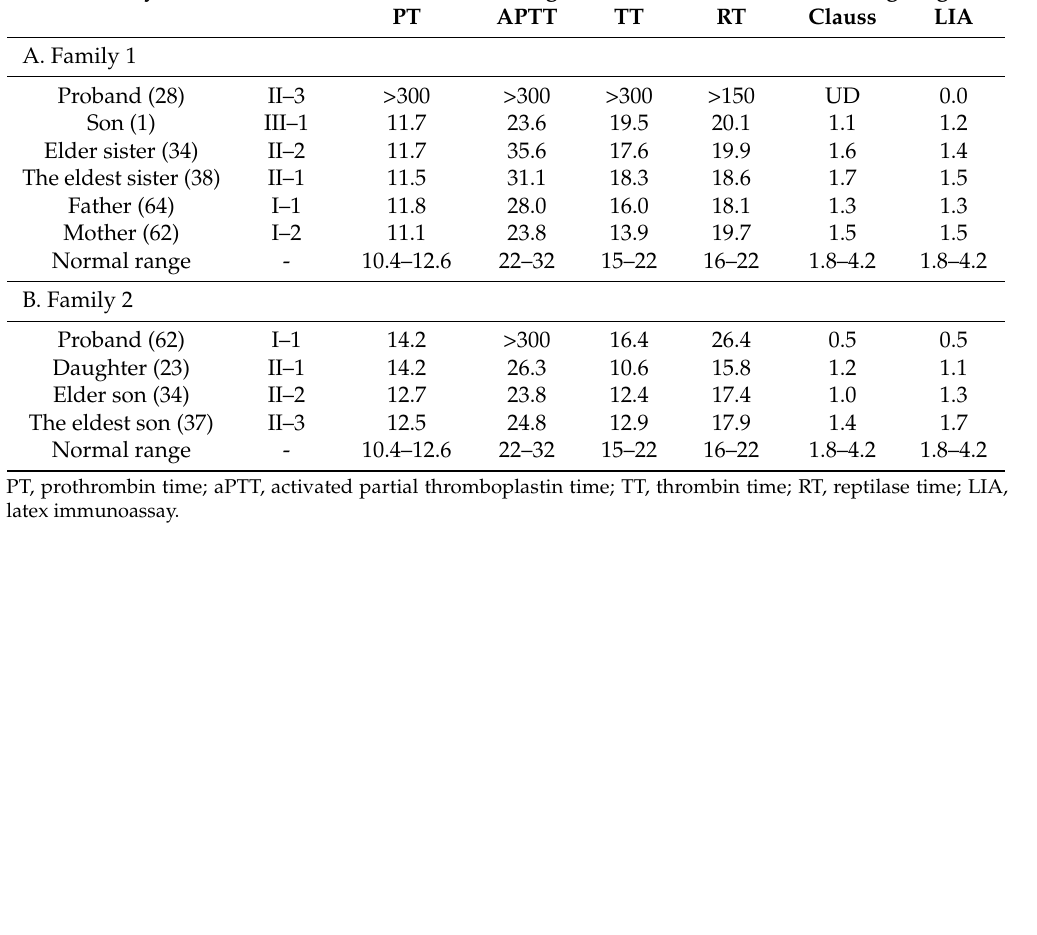
Table 2. Coagulation tests of the proband families with afibrinogenemia and hypofibrinogenemia. Family Members Clotting Time (s) Fibrinogen (g/L) PT APTT TT RT